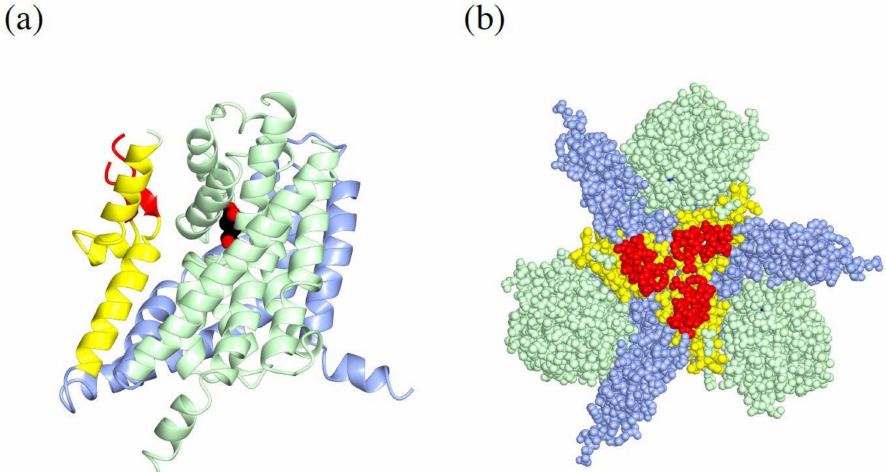
Figure 5. Structure of EAAT1 TM4: ( a ) Ribbon diagram of an EAAT1 monomer. The trimerization domain is in light blue, TM4 is in yellow, and the loop of TM4 unique for metazoans is in red. The transport domain is in light green with L -aspartate (spheres). PDBID:5LLU. ( b ) Sphere diagram of EAAT1 trimer, colored as in ( a